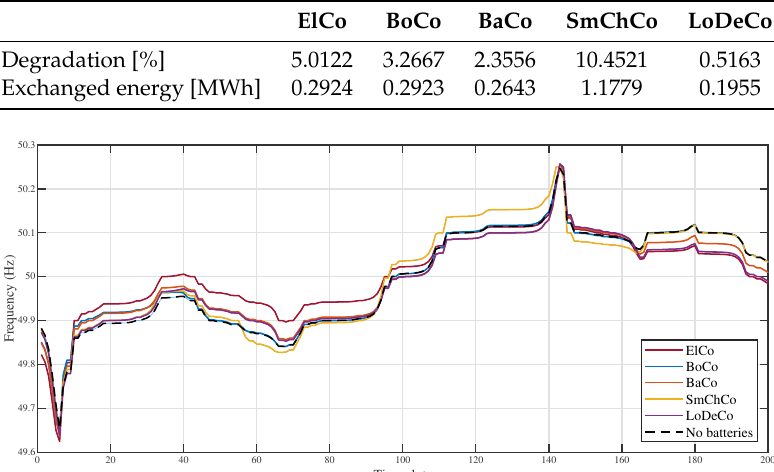
Figure 9. Power grid frequency for the different considered control strategies: focus on the first 200 time slots.